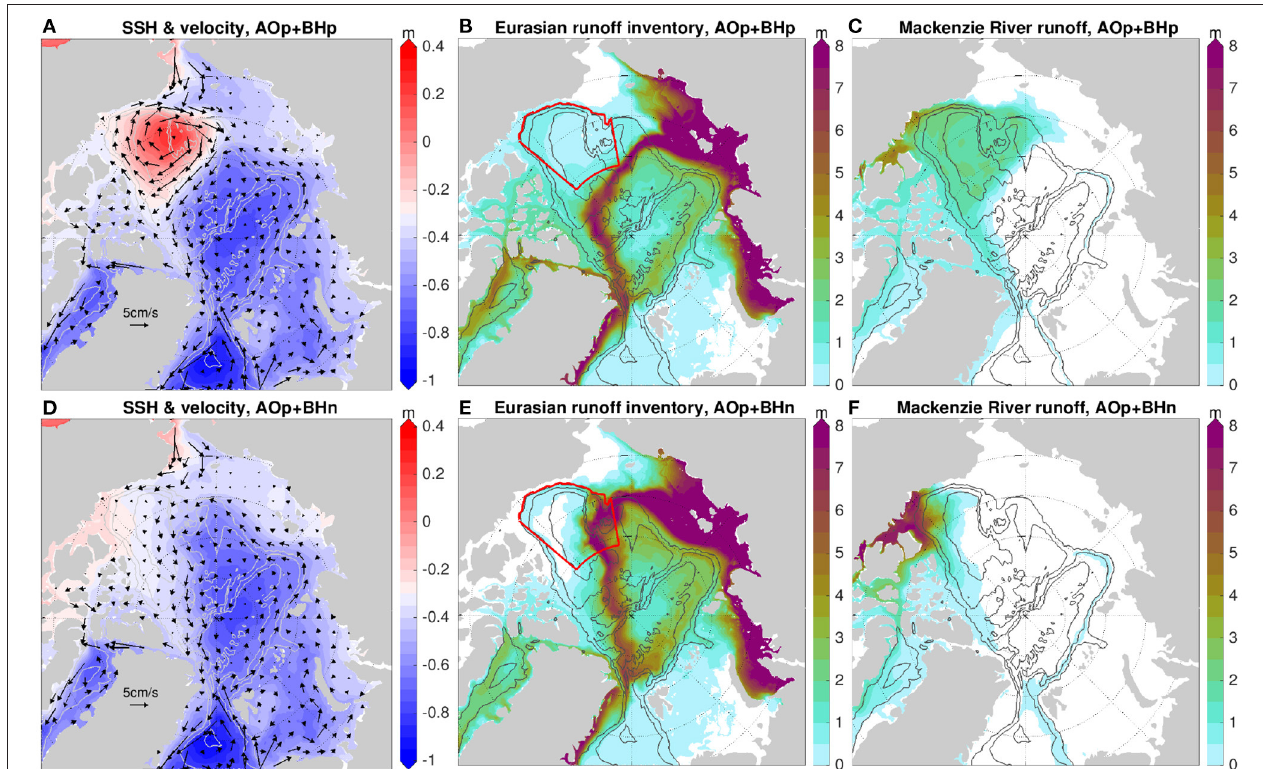
FIGURE 9 | Left: Sea surface height (SSH) and upper 150 m mean velocity in the last model year. Middle column: The inventory of Eurasian runoff (in m) in the last model year. Right: The inventory of Mackenzie River runoff in the last model year. (A–C) : the case with positive Arctic Oscillation (AO) forcing and positive Beaufort High (BH) forcing. (D–F) : the case with positive AO forcing and negative BH forcing. The red boxes in the middle column indicate the Beaufort Gyre region. The 500, 2,000, and 3,500 m isobaths are shown with gray contour